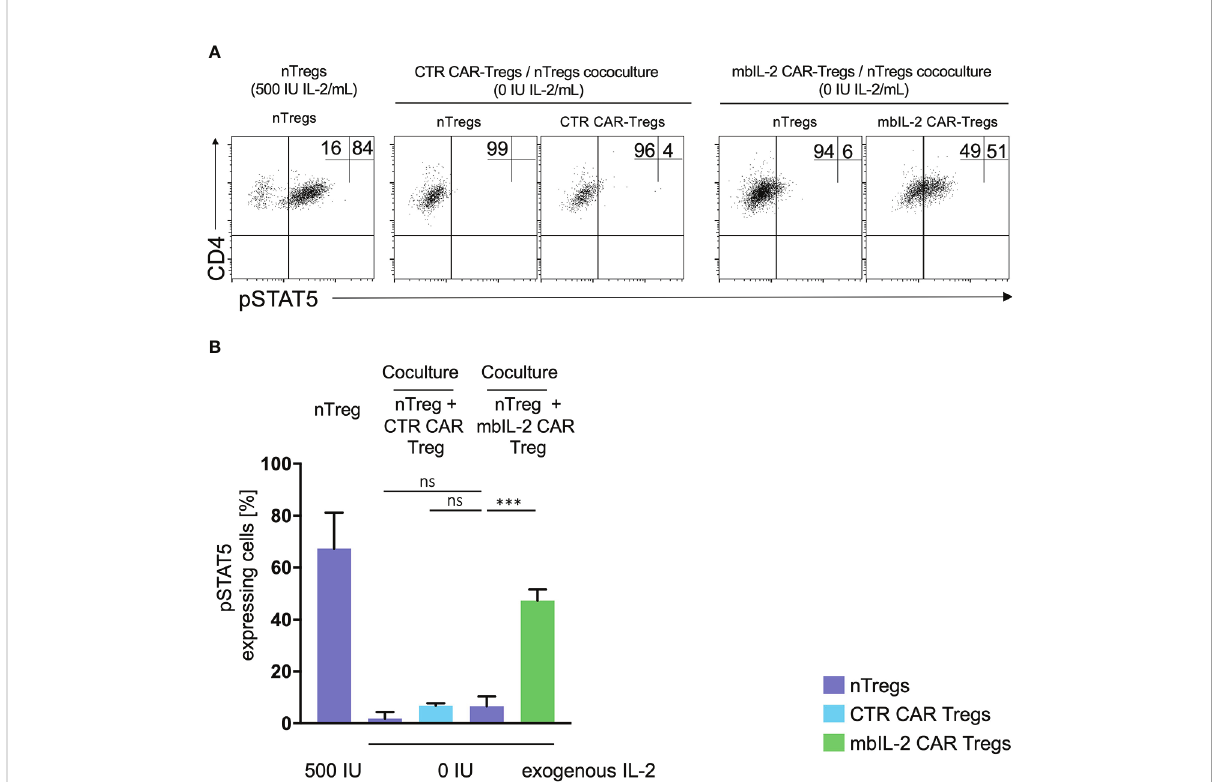
FIGURE 5 No transactivation of nTregs was observed in coculture experiments with mbIL-2 CAR-Tregs. (A) Representative dot plots of intracellular pSTAT5 staining in nTregs as well as in nTregs cocultivated with CTR CAR-Tregs and nTregs cocultivated with mbIL-2 CAR-Tregs under IL-2- free conditions. (B) Bar graph summarizing STAT5 phosphorylation in nTregs and various heterologous CAR/nTreg cocultures under IL-2-free conditions. pSTAT5 in nTregs (without cocultivation) was speci fi cally upregulated in response to IL-2. 500 IU IL-2 resulted in pSTAT5 expression in 67.5% +/- 8.1 of cells, while under IL-2-free conditions, no pSTAT5 expression in Tregs could be detected (2%, data not shown). In coculture with CTR CAR-Tregs, pSTAT5 expression was not above the basal level under IL-2-free conditions in nTregs (1.8% +/- 1.4) or CTR CAR-Tregs (6.8% +/- 0.6). In contrast, phosphorylation of STAT5 in mbIL-2 CAR-Tregs was independent of exogenous IL-2, as shown. Under IL-2-free conditions, pSTAT5 was strongly upregulated in mbIL-2 CAR-Tregs (47.3% +/- 2.4). More importantly, nTregs cocultivated with mbIL-2 CAR- Tregs in the very same well did not bene fi t from mbIL-2-driven trans-activation, as only a weak pSTAT5 signal was seen in 6.6% +/- 2.2 of analysed nTregs (n=3, 3 different individuals, signi fi cance was calculated using an unpaired t test. Error bars show the mean ± SEM. Error bars show the mean +/- SEM. n=3, 3 different individuals; signi fi cance was analysed by ordinary one-way ANOVA with Dunnett ’ s multiple comparisons test. ***P=0.0002, ns= not signi fi